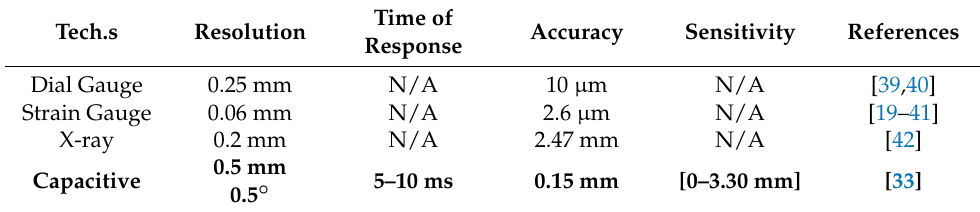
Table 2. Performance comparison of the proposed capacitive technology (last row) with respect to the current state-of-the-art. “N/A” is reported when the information is either too variable or not explicitly